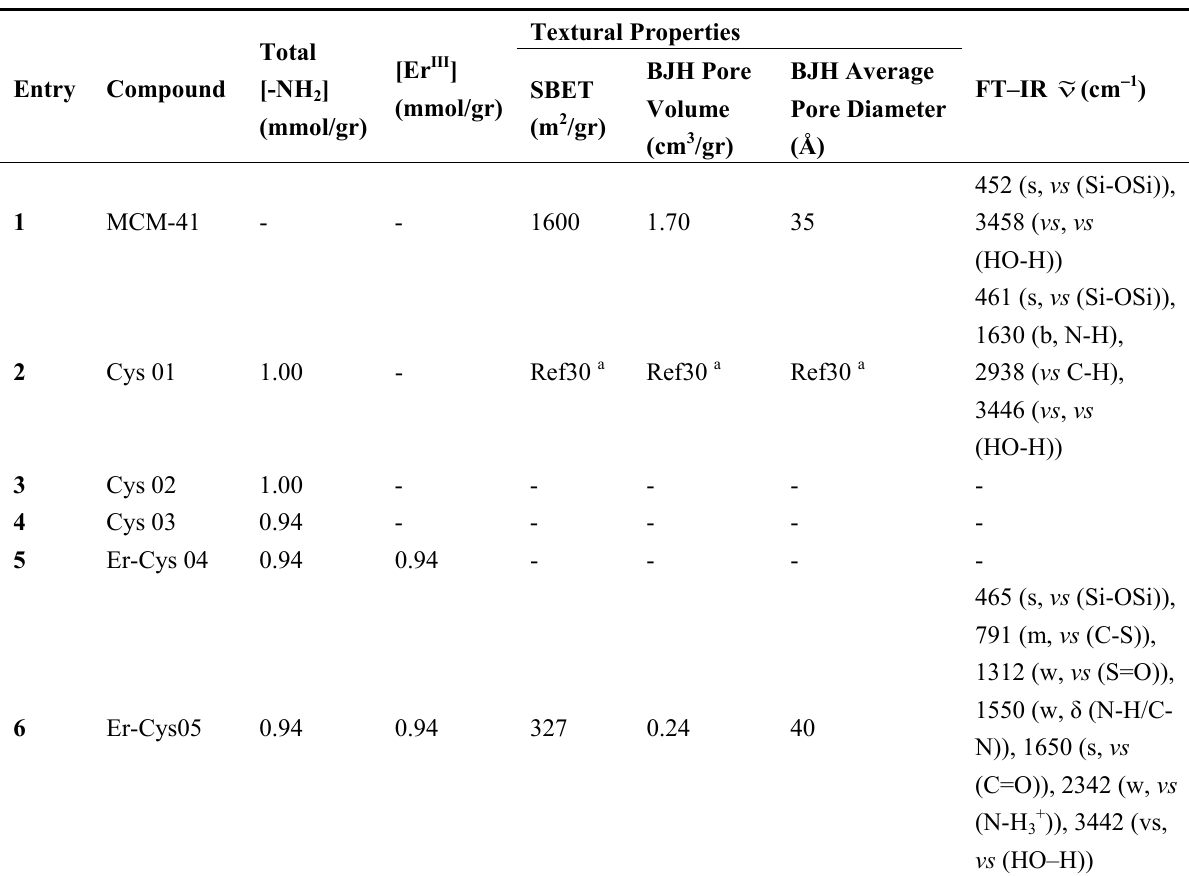
Table 1. Material characterization